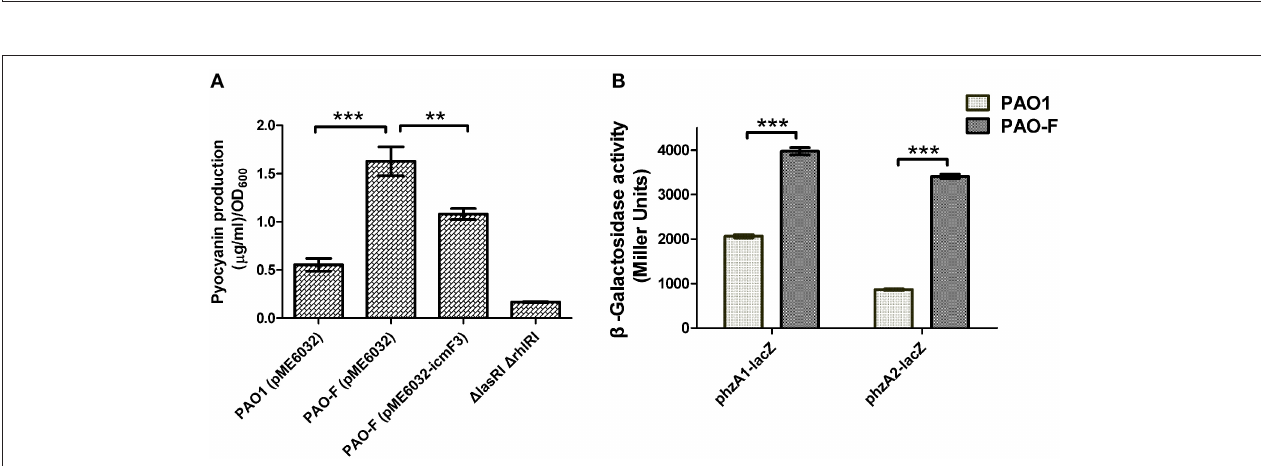
Frontiers in Cellular and Infection Microbiology | www.frontiersin.org